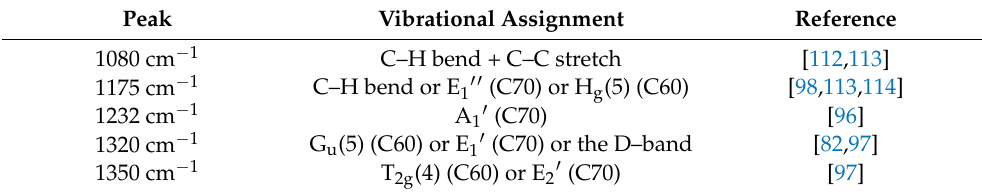
Table 2. Features observed in the Raman spectra of Carbon deposited on Si